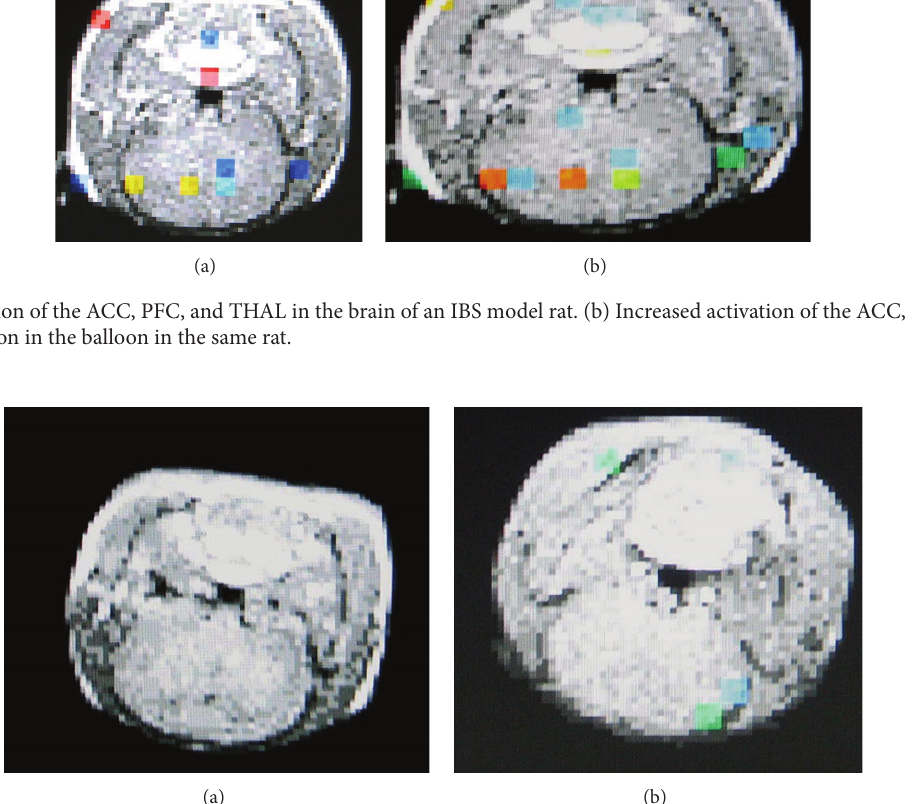
Figure 2: (a) fMRI of the center of visceral sensation in a rat in the control group; (b) activation of ACC after 10mL air inflation in the same rat.